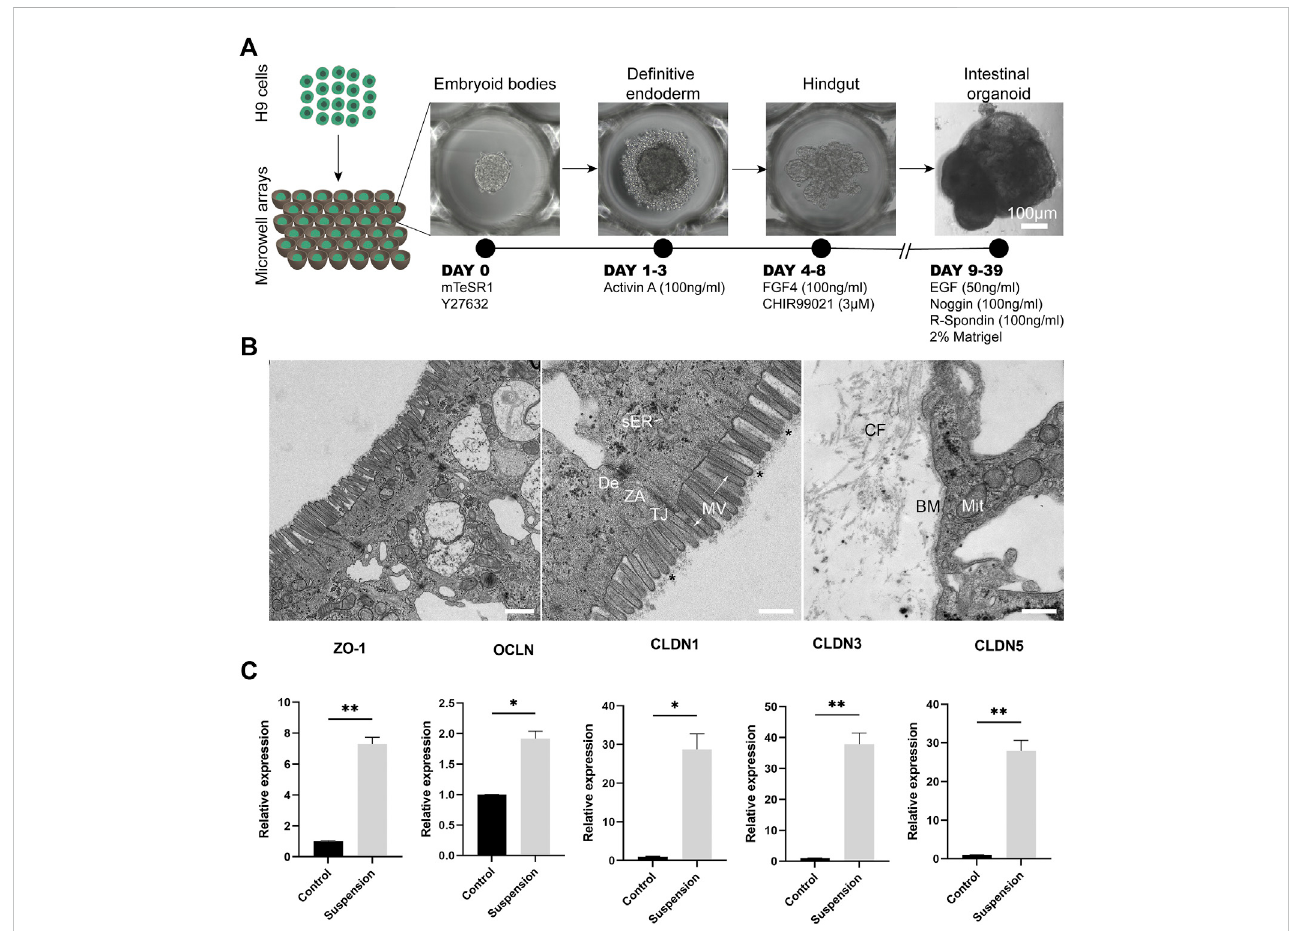
FIGURE 1 Apical-out intestinal organoids show tight barrier formation. (A) Overview of the protocol for the directed differentiation of H9 embryonic stem cells towardsintestinalorganoidswithapical-outorientation.Scalebar:100 μ m. (B) Ontheleft,alowmagni fi cationTEMimageoftheepithelialsheetofapical-out organoids demonstrating some enterocytes. In the middle image, TEM indicates the presence of apical microvilli (MV) on the outer surface of organoids. Functional ultrastructural features of the intestinal epithelium are indicated in the apical region of the enterocytes: microvilli (arrows) with core actin fi laments and glycocalix (stars), vesicles of smooth endoplasmic reticulum (sER) and intercellular junctions: tight junction (TJ), zonula adherens (ZA) and desmosome (De). In the basal region (right image), the indicated structures correspond to the basement membrane (BM), collagen fi bers (CF) and the mitochondria (Mit). Scale bars: 1 μ m (left) and 500 nm (middle and right). (C) qRT-PCR analysis shows signi fi cantly higher expression of the “ leak pathway ” regulators ZO-1 and OCLN and the “ pore pathway ” regulators CLDN1, CLDN3, CLDN5 in the apical-out intestinal organoids compared to undifferentiated control stem cells. Error bars indicate mean ± S.E.M. ( n =